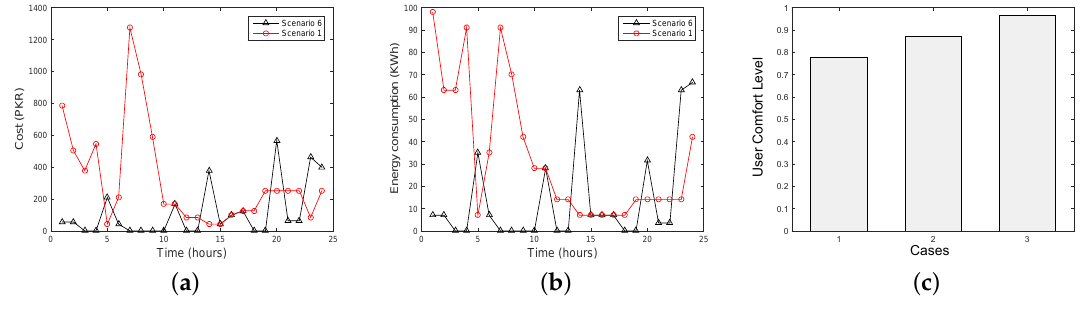
Figure 10. EMS: by using the combination of sensors, the evolutionary algorithm (BPSO) and storage devices (Scenario 6). ( a ) Cost profile (Scenario 6); ( b ) load profile (Scenario 6); ( c ) UCL when: Case 1: α , ζ = 0.3, 0.7; Case 2: α , ζ = 0.5, 0.5; Case 3: α , ζ = 0.7,